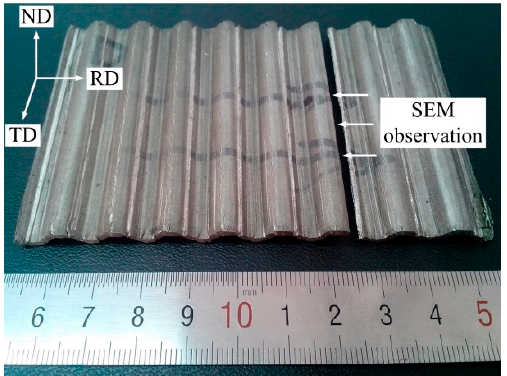
Figure 2. Fractured sheet sample after pass 3 in scheme 3 showing location for SEM observation.